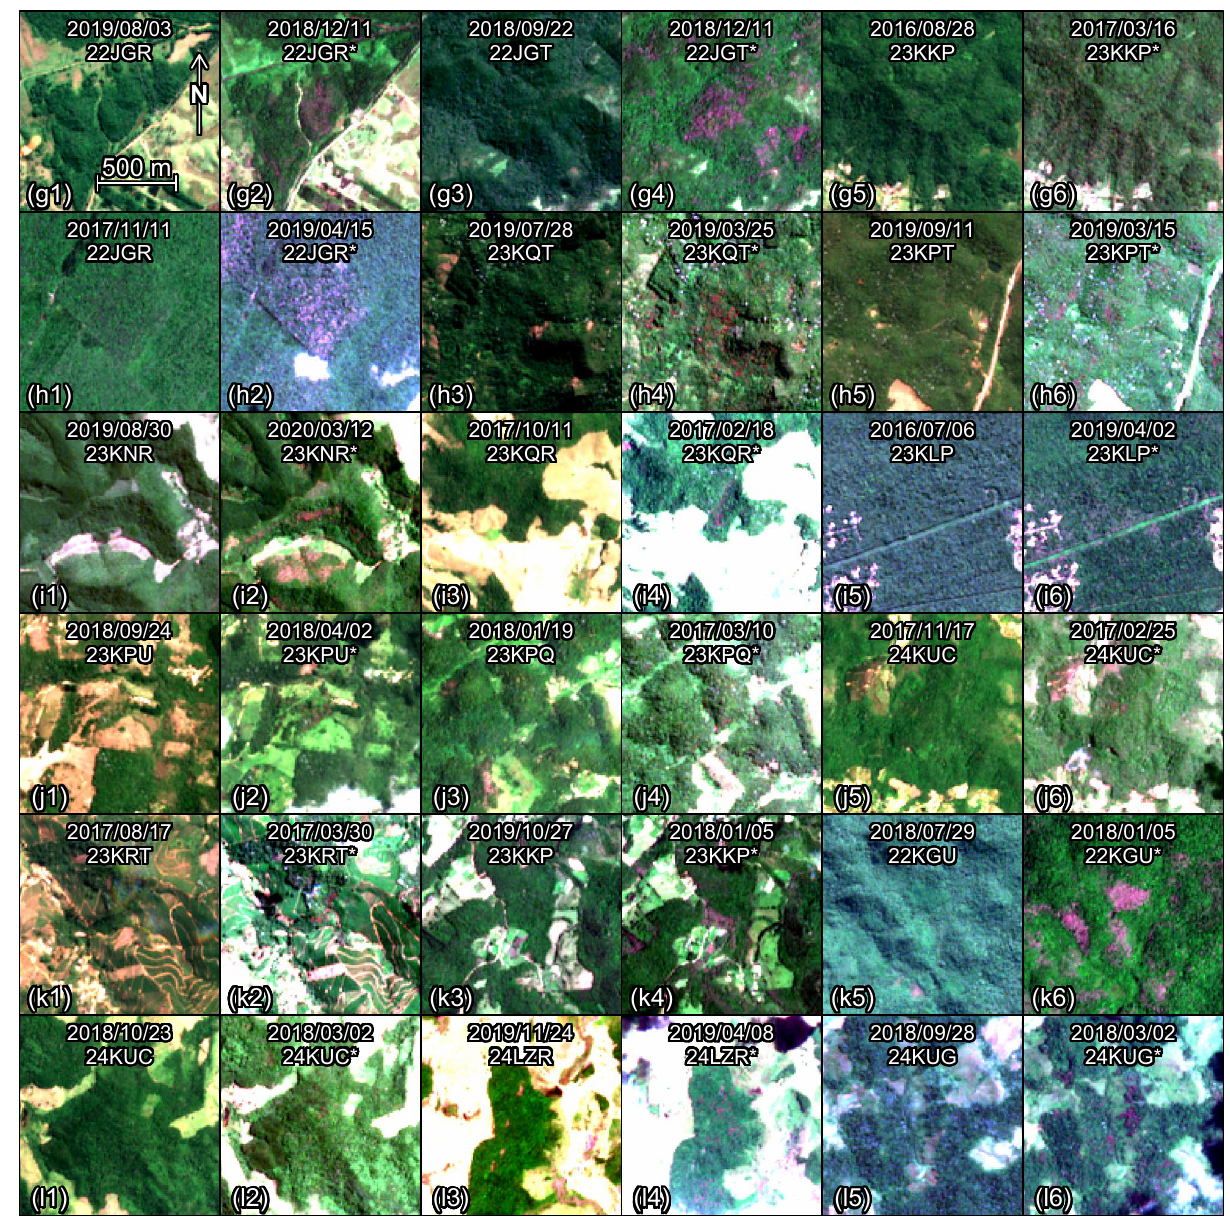
Figure 5. Sentinel-2 image subsets with Pleroma trees detected by the model (Panel II). To ease the visual detection of the pink/magenta trees, one image taken outside the blossom period and one taken within the blossom period (denoted with an *) are given for each region of detection. The dates and tile names of the Sentinel-2 images are indicated on